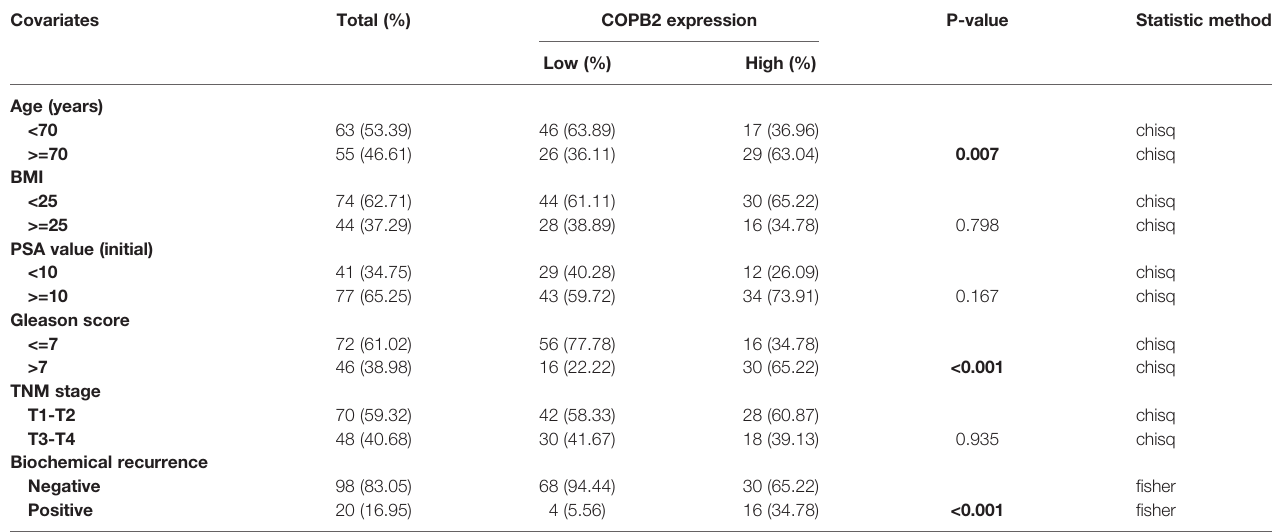
TABLE 1 | Correlation between COPB2 expression and clinicopathological factors.